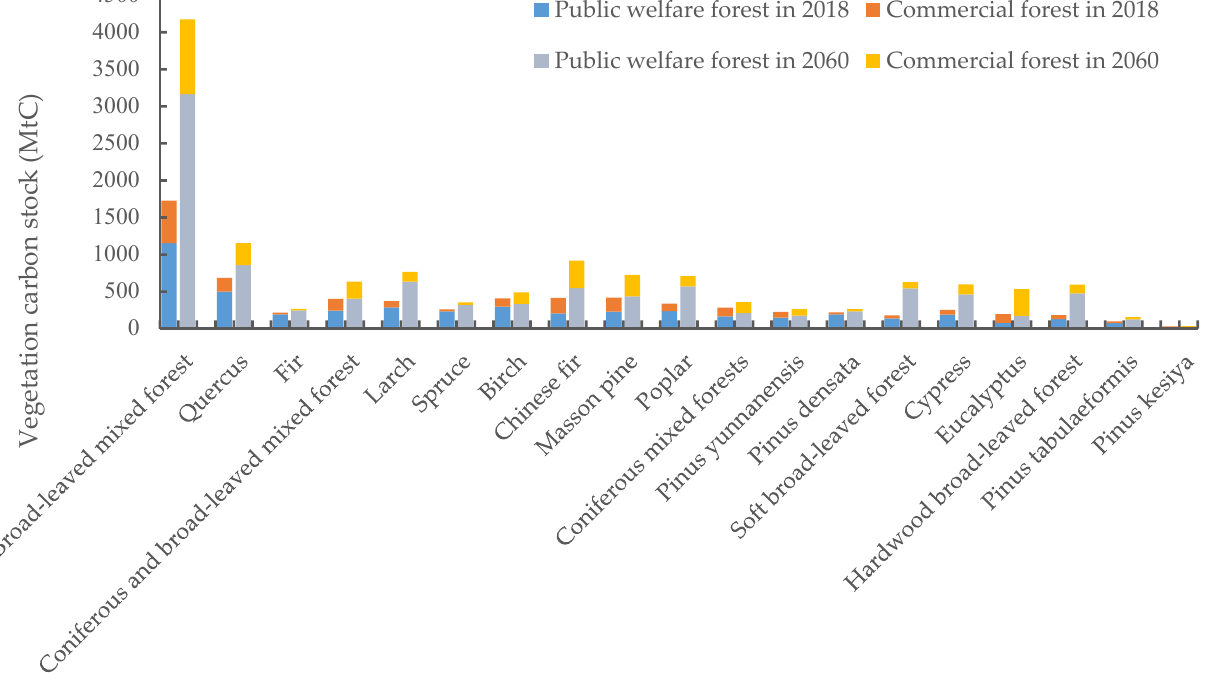
Figure 2. Vegetation carbon stocks of dominant tree species in China’s existing arbor forests. In order to depict the carbon sinks of each dominant tree species more clearly, the cumulative carbon sink of the 19 dominant tree species from 2019 to 2060 is shown